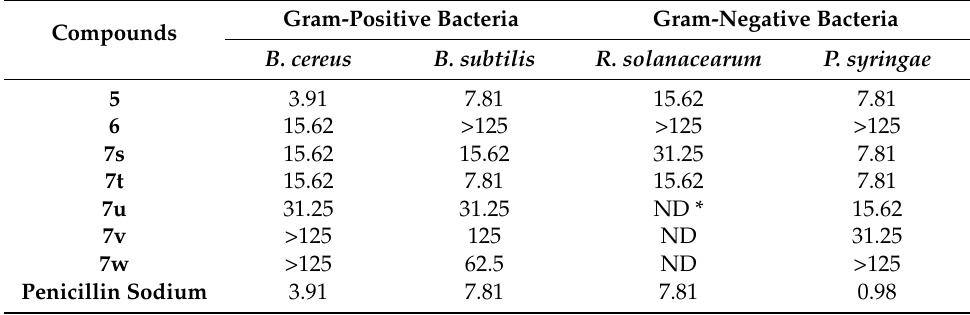
Table 3. The in vitro antibacterial activity as MIC ( µ g/mL) for compounds 5 , 6 , and 7s – 7w .